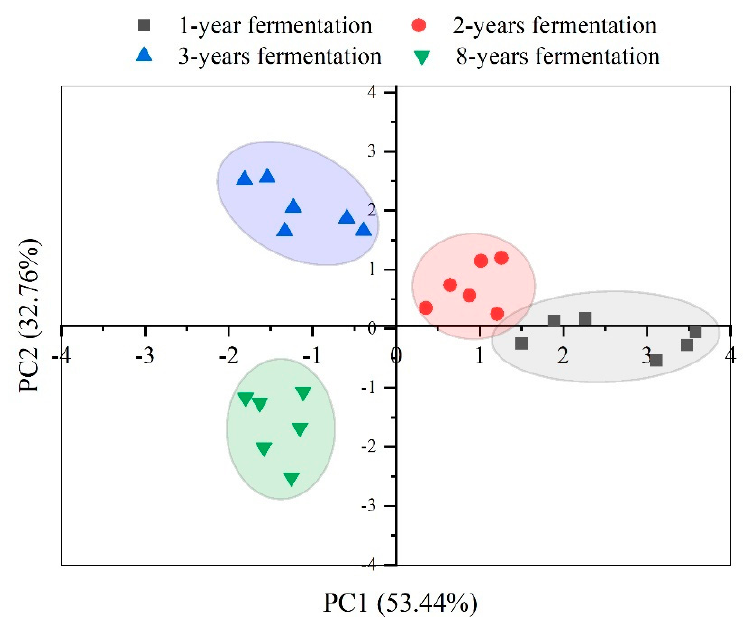
Figure 3. The PCA of all shrimp paste samples fermented for 1, 2, 3, and 8 years based on taste composition identified by E-tongue.